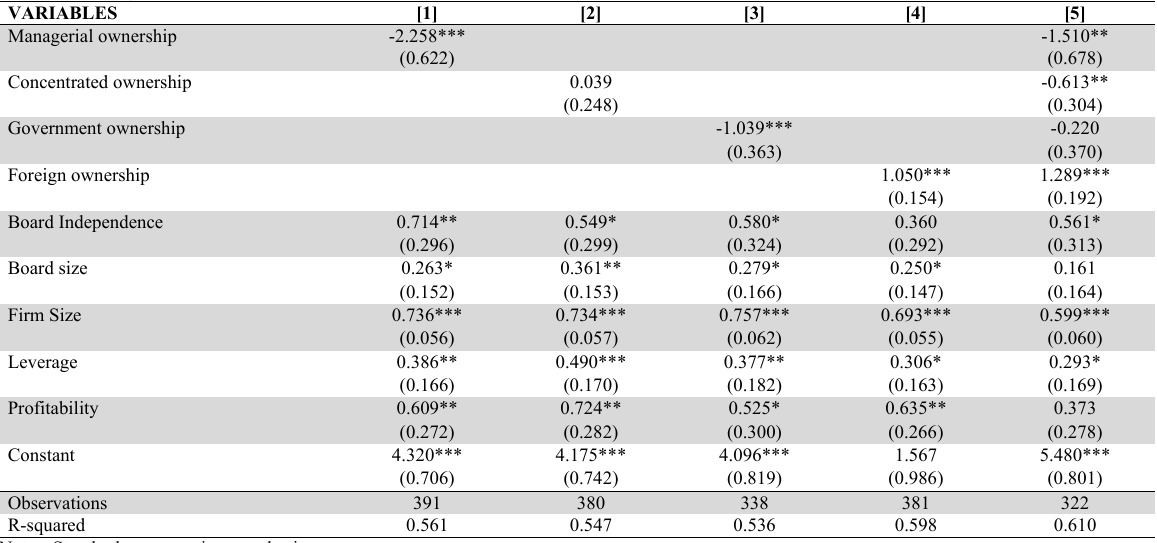
Results of Regression